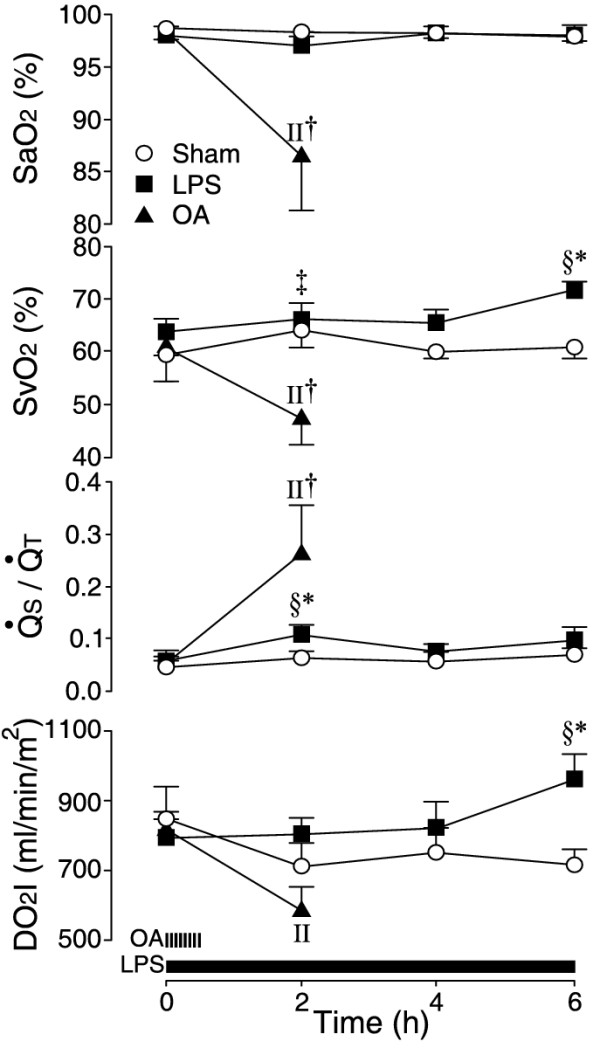
Changes in oxygenation variables in sheep. Data are expressed as mean ± standard error of the mean. *P < 0.05, LPS versus sham-operated group; †P < 0.05, OA versus sham-operated group; ‡P < 0.05, LPS versus OA group; §P < 0.05, versus t = 0 hours in LPS group; llP < 0.05, versus t = 0 hours in OA group. DO2I = oxygen delivery index; LPS = lipopolysaccharide; OA = oleic acid; Qs/Qt = venous admixture; SaO2 = arterial oxygen saturation; Sham = sham-operated; SvO2 = venous oxygen saturation.